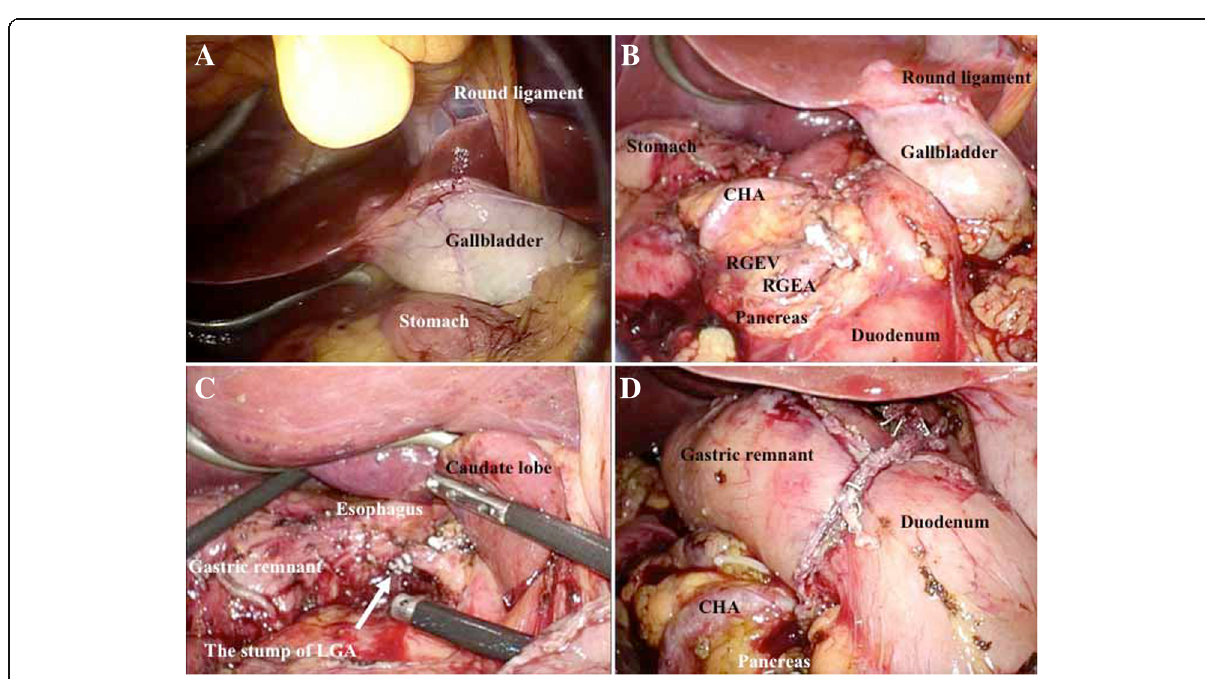
Fig. 3 Intraoperative findings. a Laparoscopic view showing inversion of the abdominal organs. b After exposing the RGEA and RGEV on the left side, we completed the dissection of lymph node no. 6. c The LGA, which was located on the right side, was transected, and lymph node no. 7 and no. 9 were dissected. d Billroth I reconstruction was then performed. CHA common hepatic artery, RGEA right gastroepiploic artery, RGEV right gastroepiploic vein, LGA left gastric artery